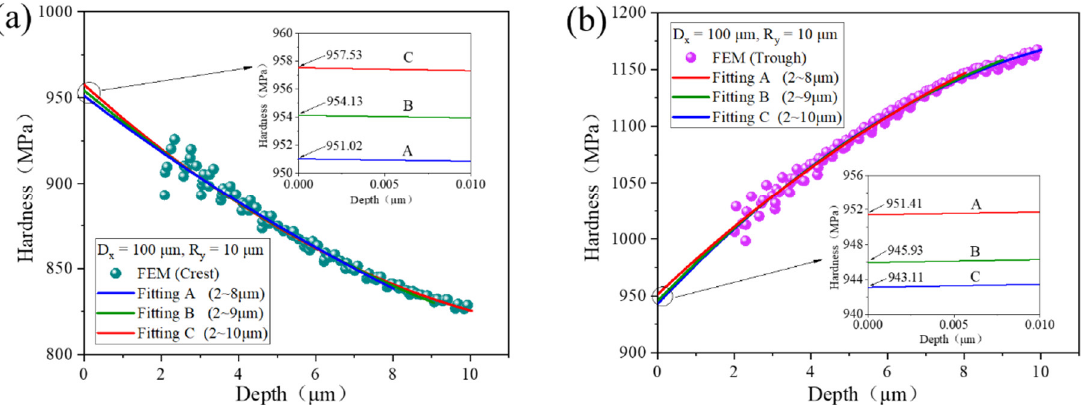
Figure 13. Hardness regression of indentation depths from 2 μm to 8, 9, 10 μm; ( a ) Crest position. ( b ) Trough position.